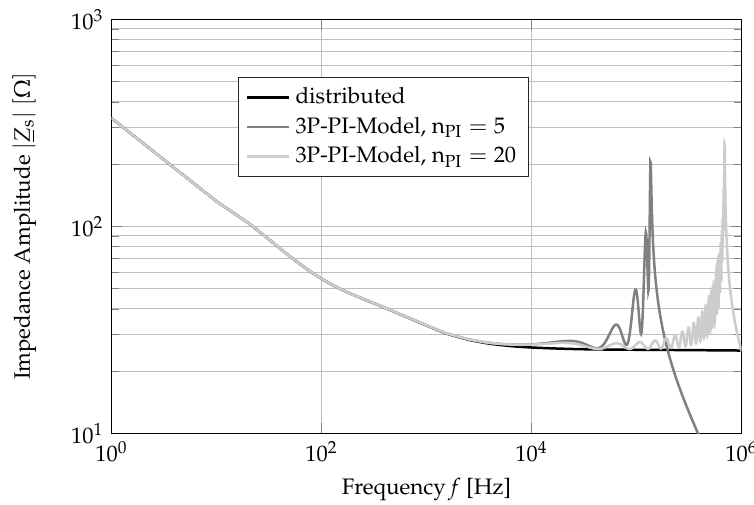
Figure 8. Impedance amplitude for the distributed-parameters model and developed 3P-PI-Model